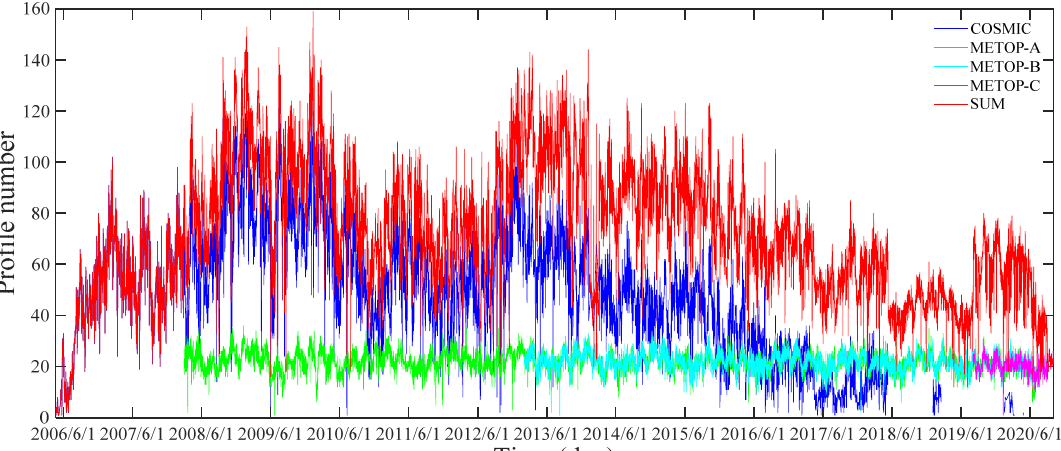
Figure 1. The number of GNSS RO events of each mission around the TP (20~50°N, 60~120°E) from May 2006 to September 2020. The red solid line indicates the total number of GNSS RO events provided by the selected missions in this paper. Blue solid line, the number of COSMIC GNSS RO events; green solid line, the number of METOP-A GNSS RO events; cyan solid line, the number of METOP-B GNSS RO events; magenta solid line, the number of METOP-C GNSS RO events.